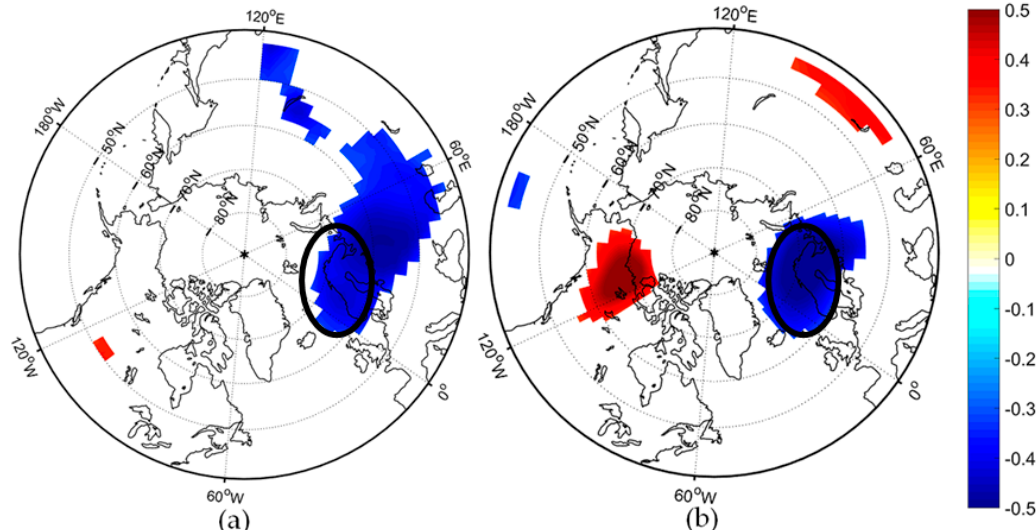
Figure 4. ( a ) Correlation coefficient distribution between sea ice index and sea-level pressure (SLP); ( b ) 500-hpa geopotential height. The colored regions passed the t test with a confidence level of 90%. All the data have been de-trended.